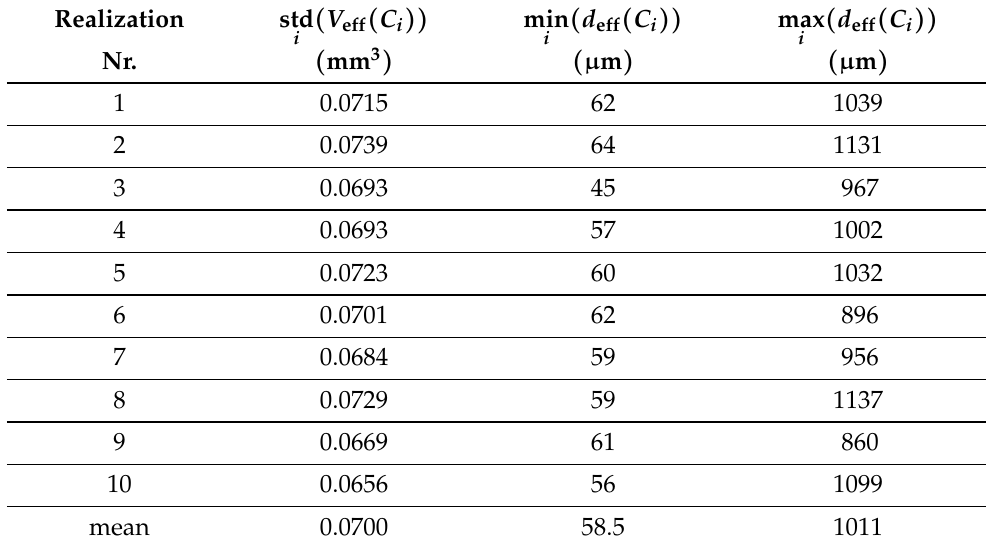
Table 3. Summary of the Inconel-617 microstructure model (cv s = 3.5 and 16,000 cells) realizations.